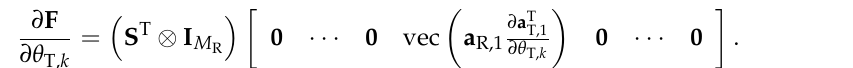
Algorithm 1. In order to speed up the convergence of the algorithm, the singular value decomposition (SVD) [24] can be used to initialize ˆ θ too small during the iteration process. Alternatively, Step 7 can be omitted if the number of targets is the estimation error